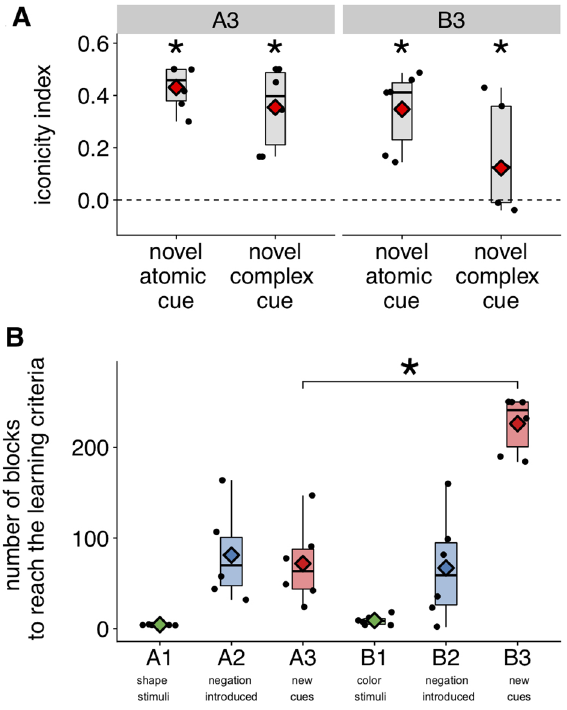
Figure 4. Results (Experiment 2). ( A ) Early iconicity bias. The iconicity index is the difference score between the proportion of iconic responses and the chance level, i.e. 0.5., computed at the beginning of the critical learning stages A3 and B3 (first 10% of trials) for the novel atomic cue and the novel complex cue. Each dot represents a participant. Consistent with Experiment 1, baboons initially displayed an iconicity bias: they chose the iconic responses above chance, regardless of the feedback they received (that is, for both novel atomic and complex cues in A3 and B3). Asterisks denote statistical significance ( > 0 ). ( B ) Compositionality effect. Average number of blocks needed to reach the learning criterion in each learning stage. A3 was learned faster than B3. Diamonds show condition means. Each dot represents a participant. Asterisks denote statistical